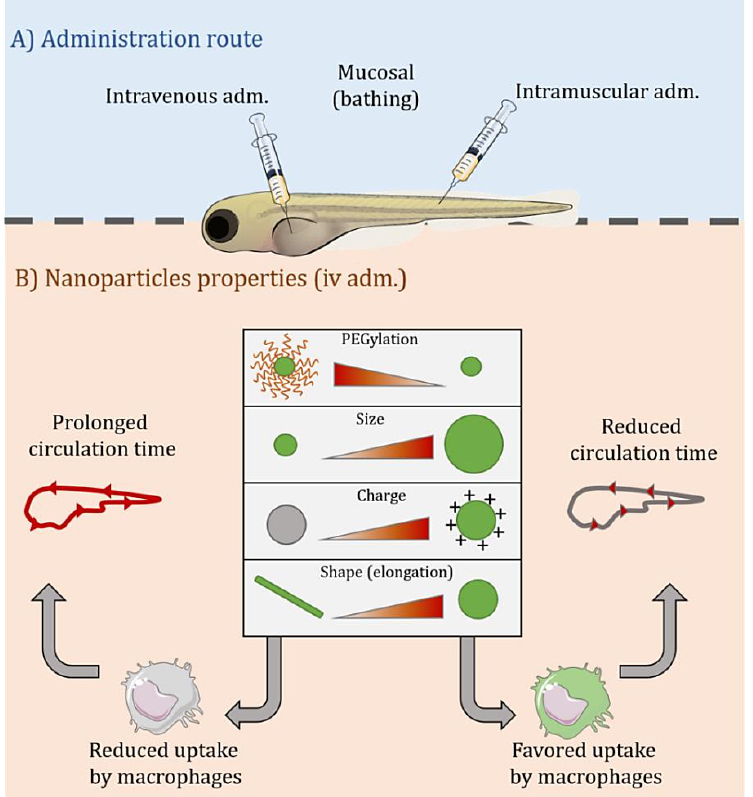
Figure 2. Biodistribution of nanoparticles in zebrafish is related to their interaction with macrophages. The biodistribution of nanoparticles in zebrafish embryos is mainly dictated by ( A ) the administration route and ( B ) the physicochemical properties of the nanoparticles. Among the characteristics that most impact the circulation time after intravenous administration are the degree of PEGylation, the particle size, the surface charge and the shape of the particles. By tuning these properties, the uptake by macrophages can be minimized and the circulation time can be prolonged. Zebrafish models have also been used to study NP-biodistribution through other routes of administration. Upon intramuscular (i.m.) injection in zebrafish, NPs generally only spread along the muscle tissue close to the injection site, at least for short times [86]. As time goes by, the NPs are commonly internalized by macrophages to be cleared [86]. In our previously mentioned work, after i.m. injection, the 70 nm NCs disseminated fur- ther than 200 nm NCs, spreading through all the myomere and limited by myosepta [70]. Positively charged NCs (chitosan based) recruited more macrophages than negatively charged (inulin based) NCs, following a similar pattern to the i.v. route. To study the mu- cosal administration of new therapies using zebrafish, NPs can be simply incubated in water. Verrier and colleagues found that 200 nm PLA-NPs were able to cross the epithelial barrier of different mucosae (nasal, gills, gut, and skin) and be accumulated in antigen presenting cells, such as dendritic cells, macrophages and B cells in the gills and skin [100]. Interestingly, the NPs were able to enter the bloodstream through the gills, and to then